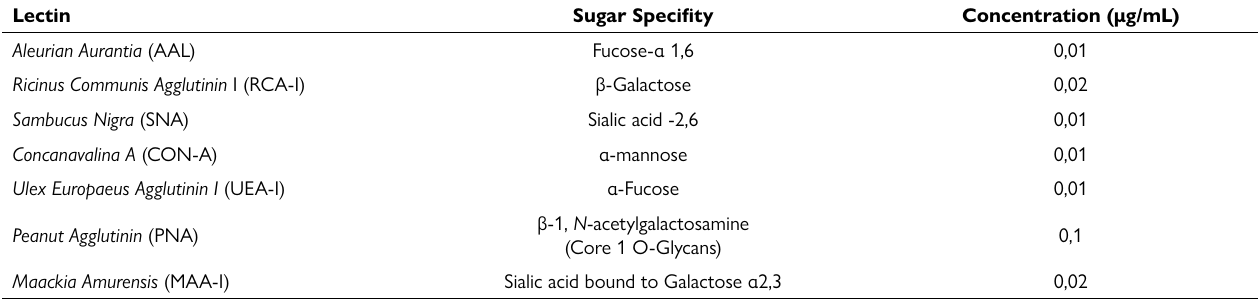
Table 1. Panel of Lectins used and glycans